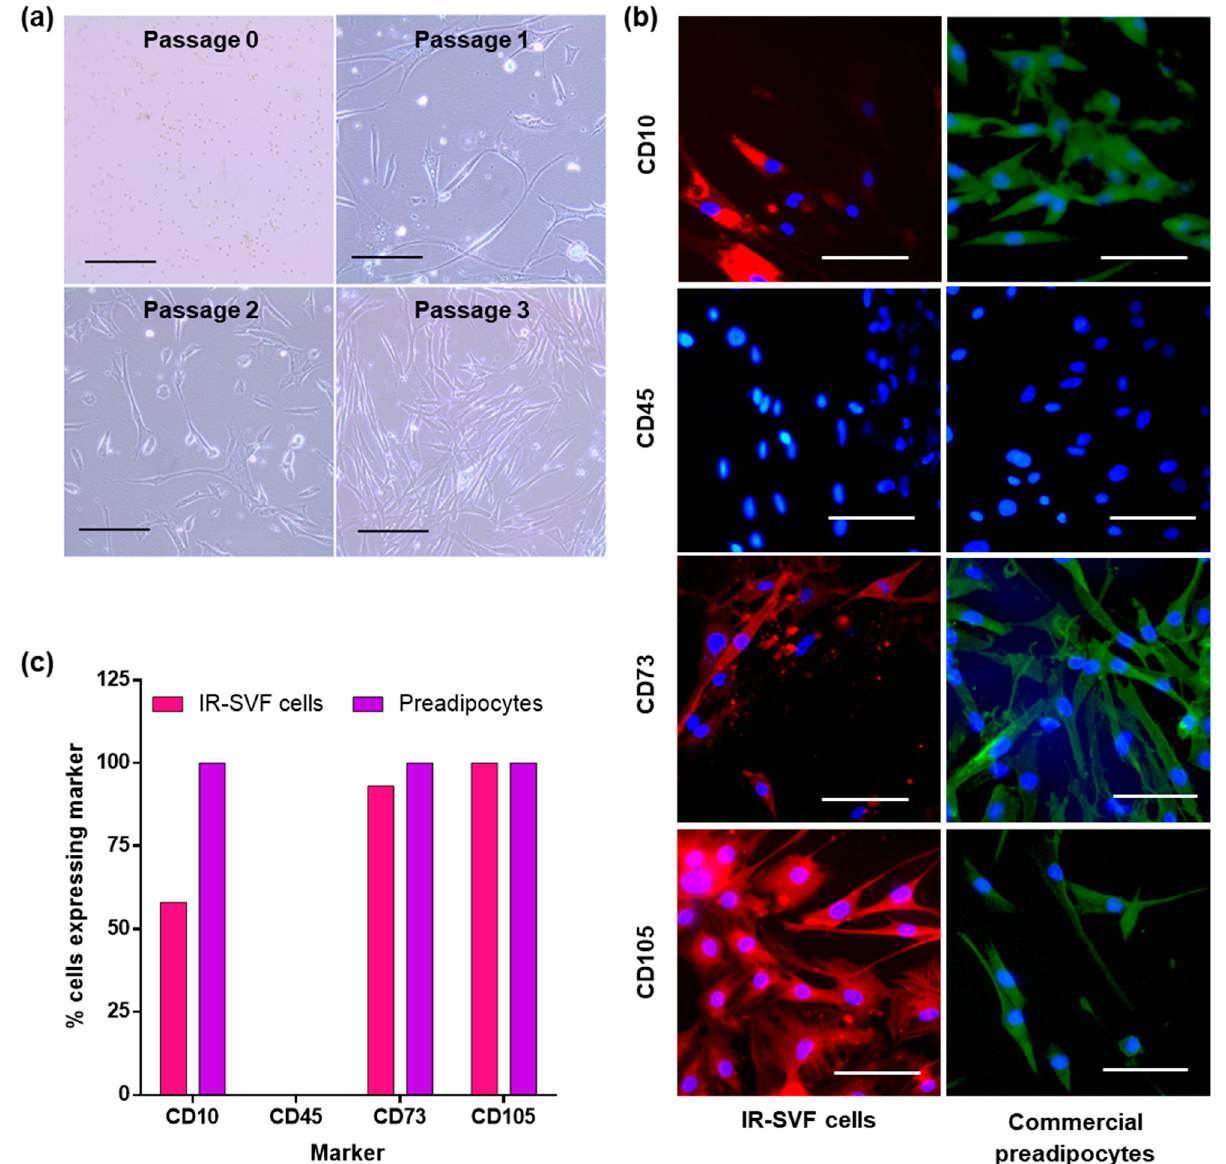
Figure 2. Characterisation of IR-SVF cells. ( a ) Random images of cells were taken using a light microscope at × 200 magnification, of IR-SVF from passages 0–3. ( b ) The expression of preadipocyte markers CD10, CD73 and CD105, as well as the negative control CD45, was assessed using immuno- cytochemistry in both IR-SVF and commercial preadipocytes. Multiple random fields of view were captured at × 250 magnification. Primary antibodies for each cell type were identical; secondary antibodies for IR-SVF were RFP-tagged and for preadipocytes were GFP-tagged. ( c ) From the im- munocytochemistry images, the percentage of cells (identified by nuclei) staining positive for each marker was quantified and expressed as a percentage. n = 1 donor for each cell population; scale bars = 100 µm. GFP, green-fluorescent protein; IR-SVF, stromal vascular fraction from irradiated tissue; RFP, red-fluorescent protein.